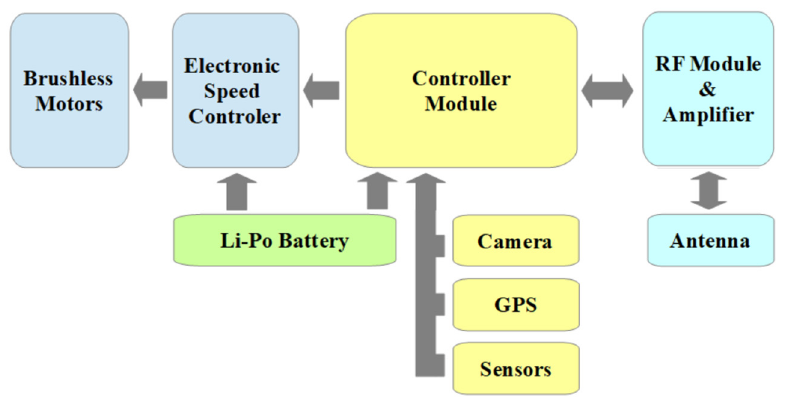
Figure 4. Main components of a typical drone [29,30].